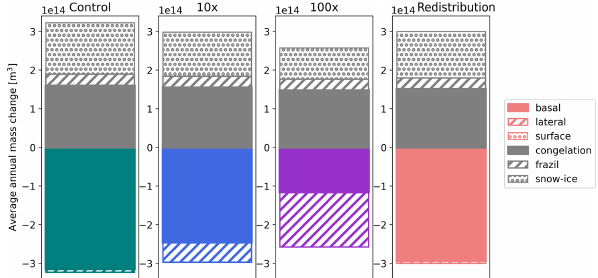
Figure 10. Annual Southern Hemisphere mass budgets for all sen- sitivity runs (from left to right: control, 10 × lateral melt, 100 × lat- eral melt, redistributed lateral melt). Grey areas represent volume of growth terms – congelation (solid), frazil (hashed), and snow–ice (dotted) – and colored areas represent volumes of melt terms – basal (solid), lateral (hashed), and surface (dotted). Results shown are av- erages over the last 5 run years for the redistributed lateral melt run and the last 25 years for all others. Figure 11. Daily (a) open-water-formation efficiency (OWFE) of